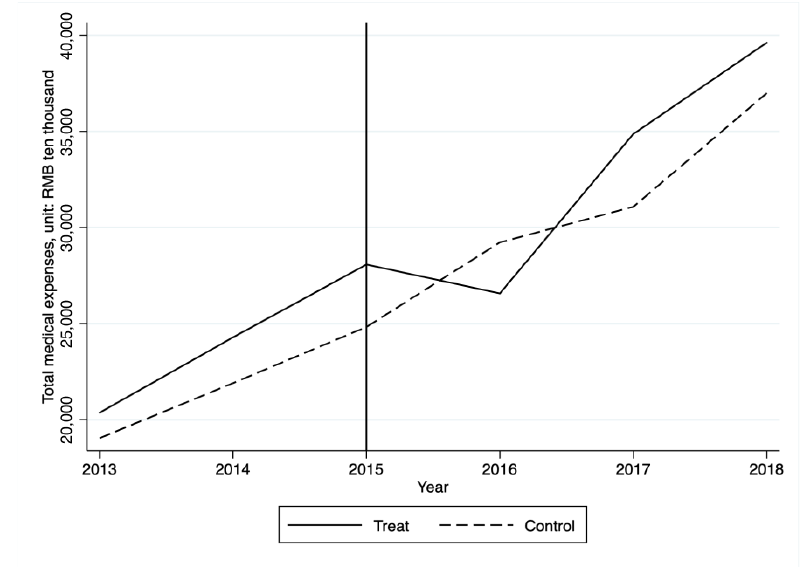
Figure 1. Trends in medical expenses borne by the UURBMI and UEBMI. This figure plots the trend of annual total medical expenses borne by the UURBMI and UEBMI between treatment group and control group. The solid vertical line indicates the timing of SPR policy implementation in 2015.